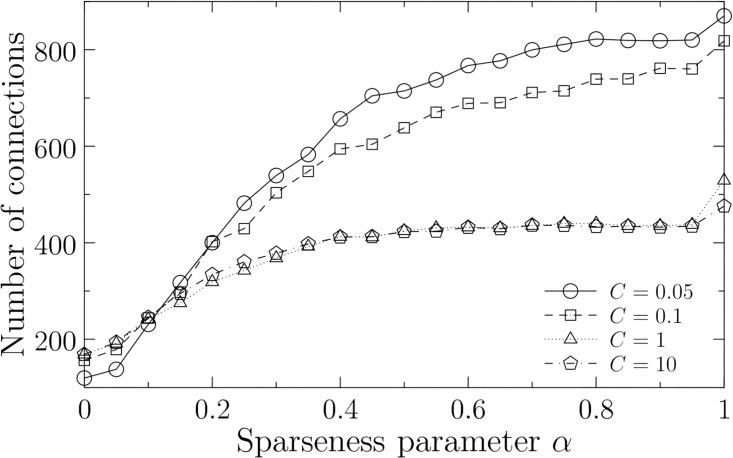
Number of estimated connections as a function of sparseness parameter α.We show the average number for each soft-margin parameter C in 1,000 optimal solutions. The other parameters are fixed at d = 2 [h], dmin = 0 [h], dmax = 2 [h], and θ = 1.